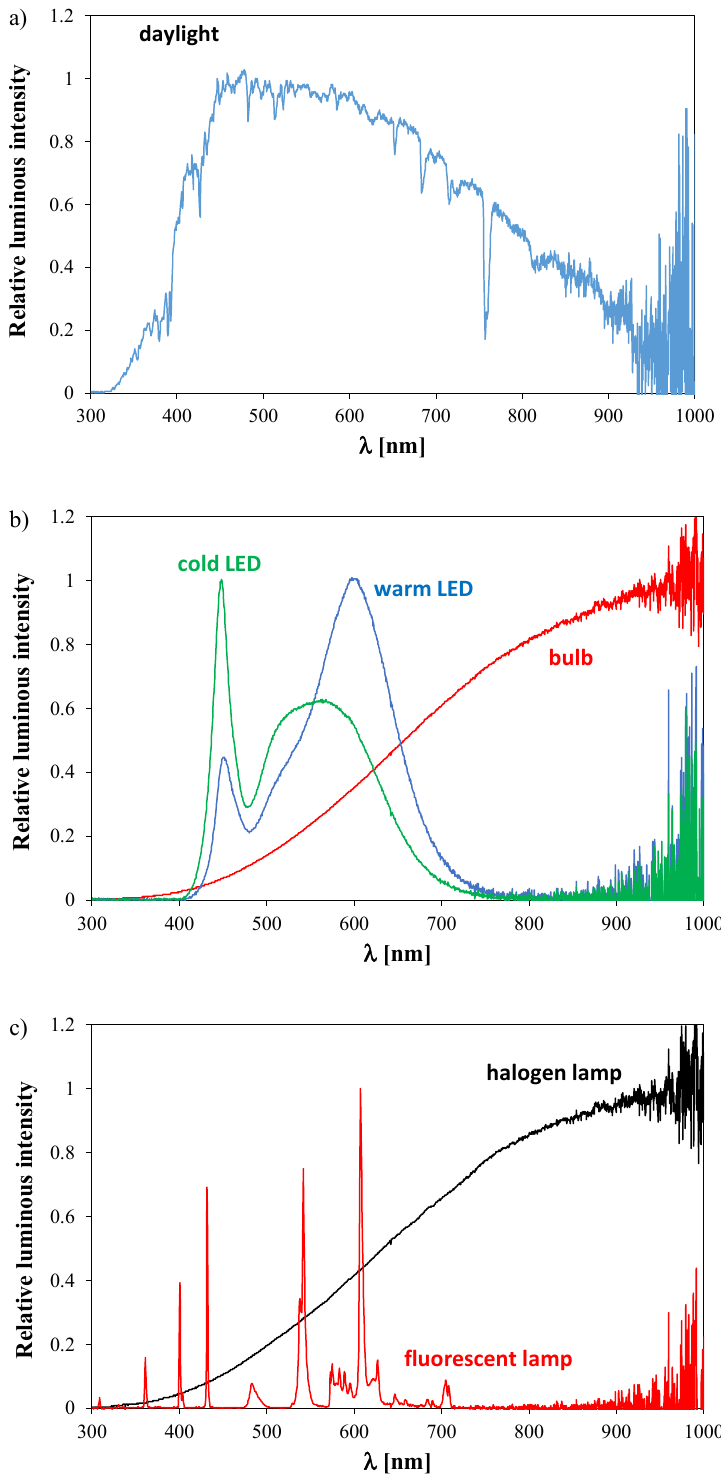
Figure 3. The measured relative spectral radiation distribution of the daylight ( a ), the bulb and the LED lamps ( b ), the halogen lamp, and the fluorescent lamp ( c ). It can be observed in Figure 3a that radiation is emitted in the wavelength λ range wider than the wavelength range of the used instrument. According to the information given, e.g., in [46,47], the bandwidth of the daylight contains wavelengths in the range from 120 nm to 1000 µm, but 98% of solar energy is emitted in the range from 0.3 to 3 µm.